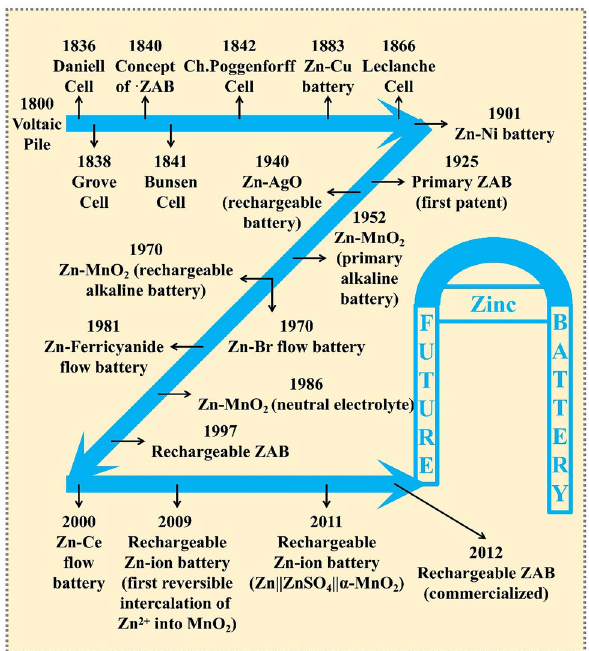
Fig. 1 Part of the development history of Zn